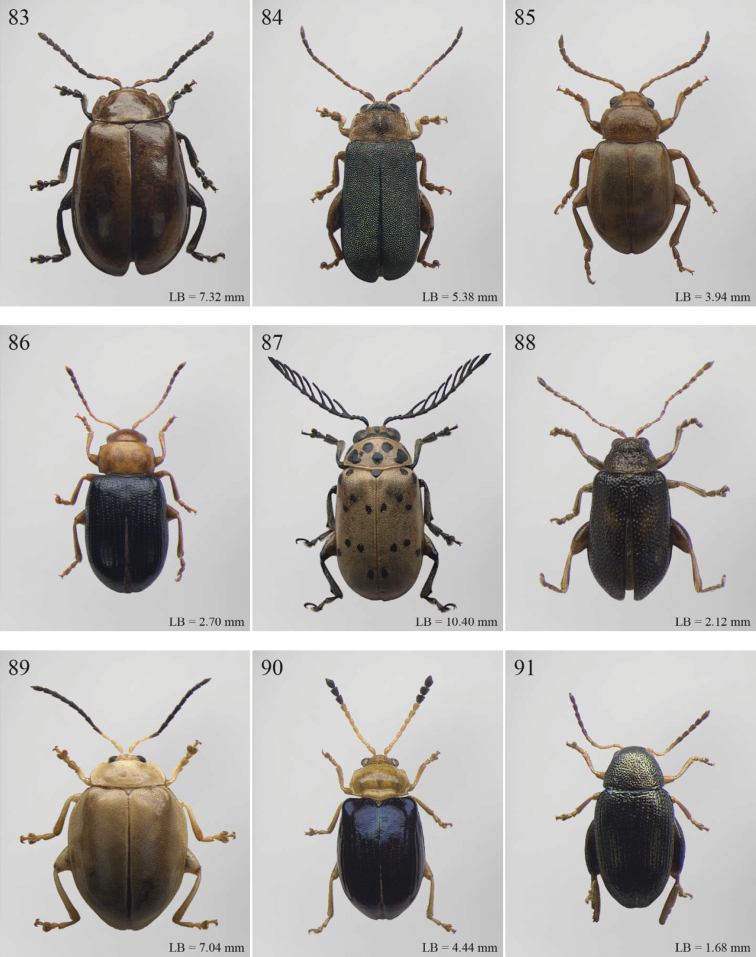
Habitus. 83
Physomandroya melanarthra (Fairmaire) 84
Physonychis violaceipennis (Baly) 85
Podagrica oneili (Jacoby) 86
Podagrica (ex Podagricina Csiki) aethiopica (Chapuis) 87
Polyclada bohemani (Baly) 88
Pratima variabilis Maulik 89
Pseudadorium amplum (Weise) 90
Pseudophygasia analis (Harold) 91
Psylliodes calcarata (Bryant).